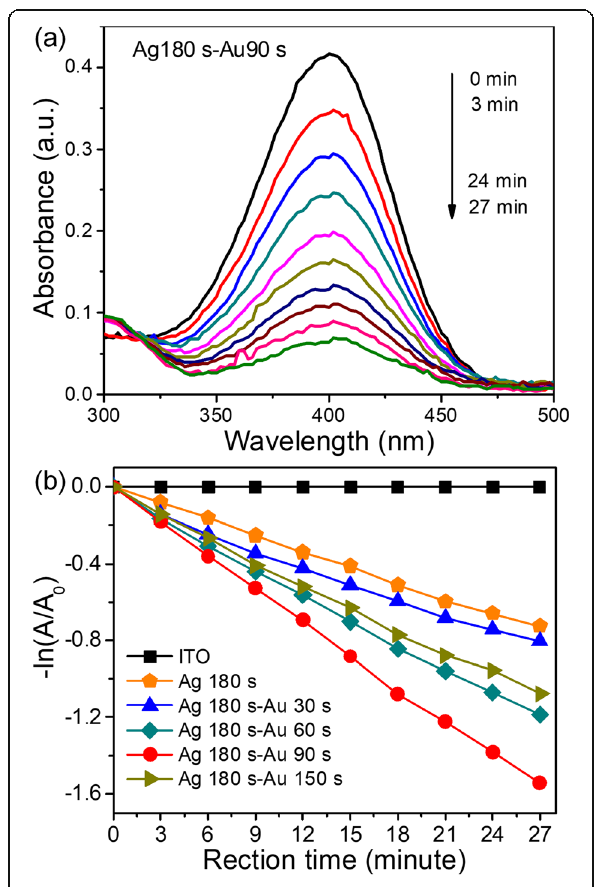
Fig. 5 a Time-dependent UV-vis absorption spectra of the reduction of 4-NP by NaBH 4 in the presence of dendritic Au/Ag bimetallic nanostructures (Ag180s-Au90s). b Plots of -ln(A/A 0 ) at λ = 400 nm as a function of reaction time in the presence of catalysts with the same